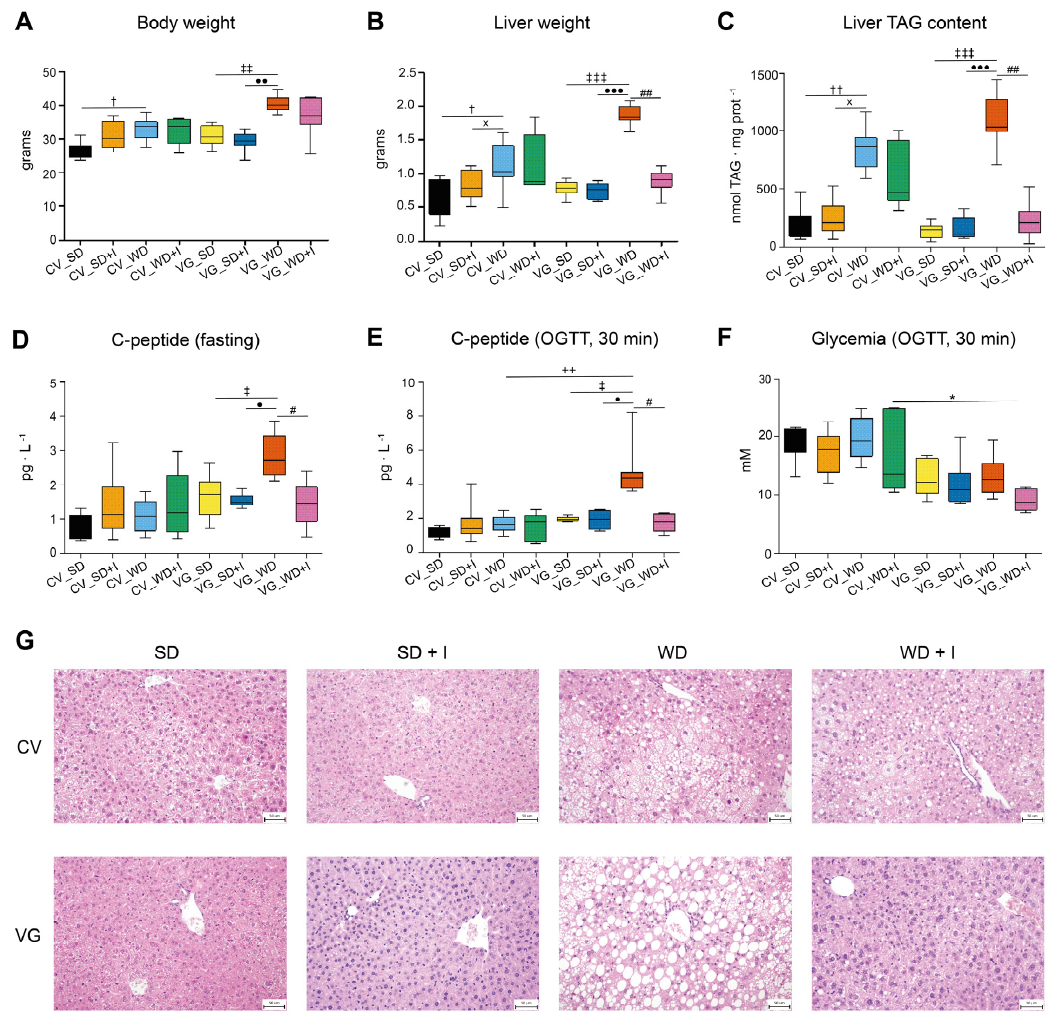
Figure 2. Effect of the diet and inulin supplementation on body composition and glucose homeosta-